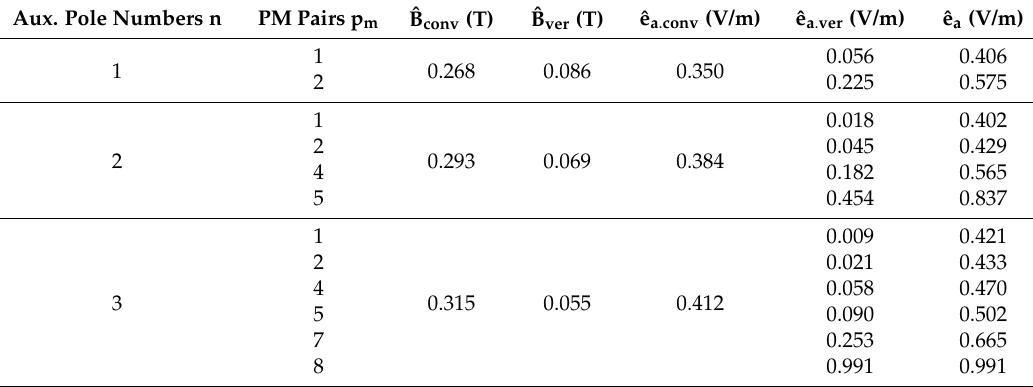
Table 3. Flux densities and induced voltages of a